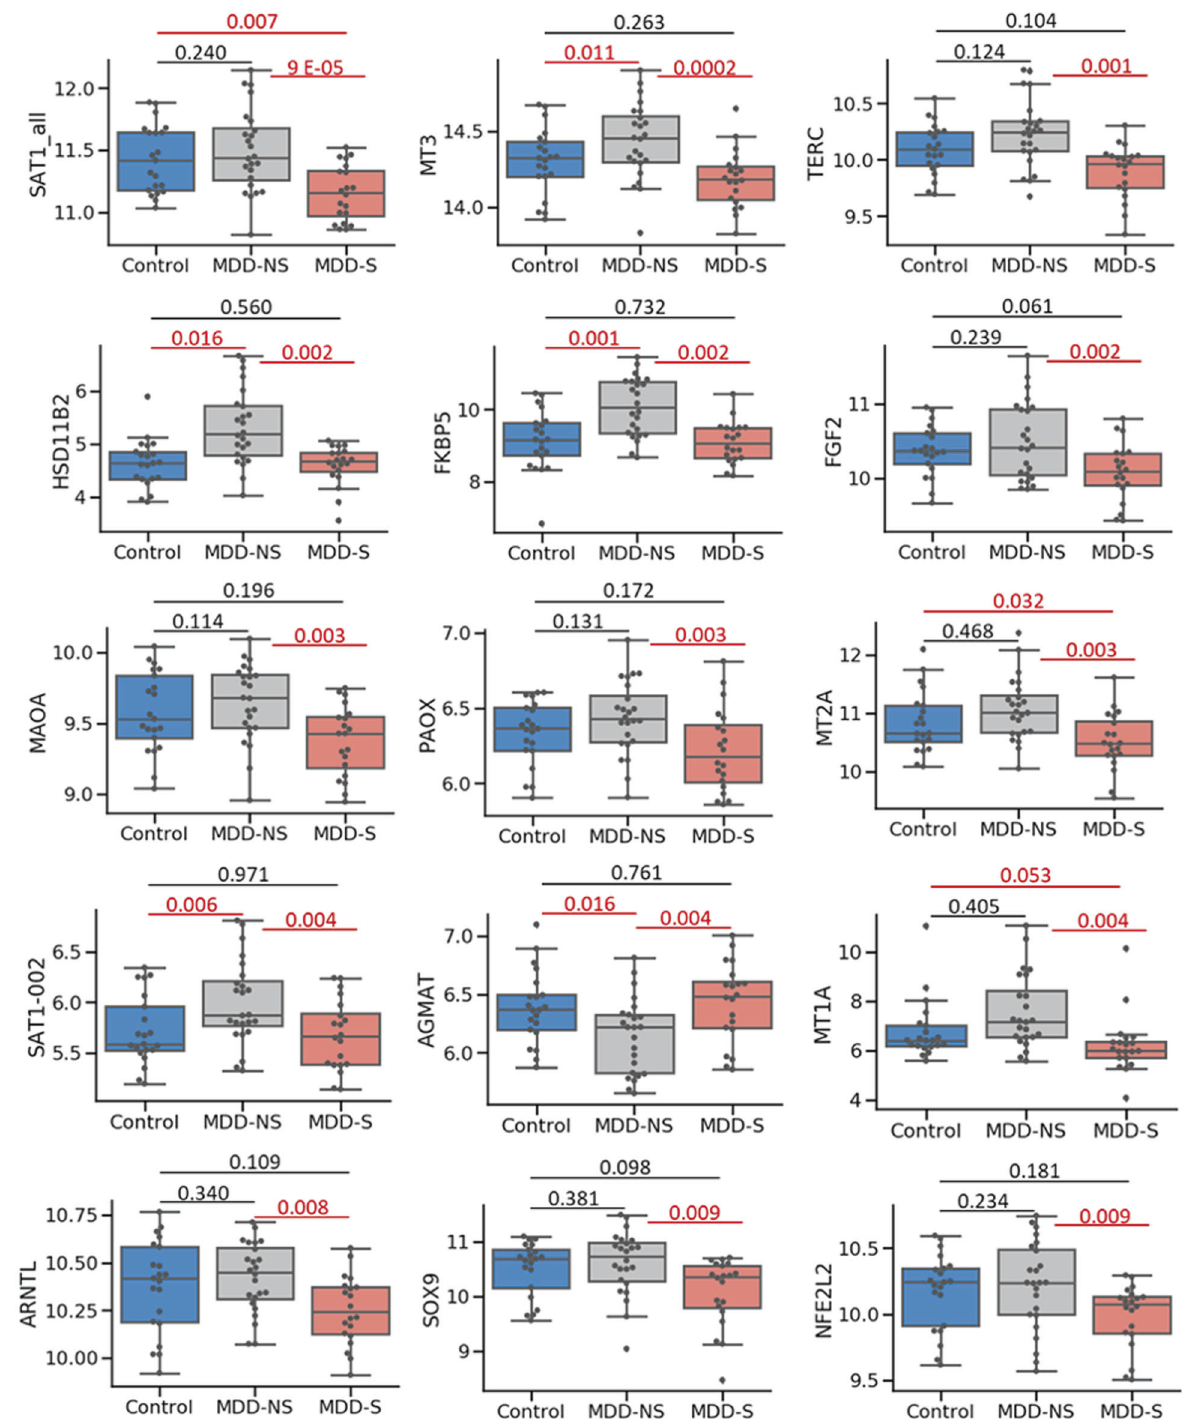
Fig. 2 Genes differentially expressed in brain. Top fi fteen ( p -value ≤ 0.01) differentially expressed genes between MDD-S and MDD-NS in DLPFC. The displayed genes all passed FDR correction for multiple comparisons at Q ≤ (Metallothionein 3) gene, which was decreased in suicides. A (for 16 of the genes)) (Fig. 2 and Table 3). The top gene total of four metallothioneins (MT3, MT2A, MT1A, and MT1X) were differentially expressed between MDD-S and MDD-NS was SAT1. signi fi cantly reduced in MDD-S, although these same genes did In addition to the main SAT1 probe (SAT1_all), measuring all splice not reach signi fi cance in blood. Metallothioneins are known to be variants of the SAT1 gene, two additional splice variant speci fi c involved in neuroprotection against, among other things, the probes (SAT1-002 and SAT1-001) were also signi fi cantly reduced in deleterious effects of long-term increases in cortisol levels [44]. MDD-S (Fig. 2 and Table 3). The second most signi fi cant gene The decreased expression of SAT1 and MT3, as well as other between MDD-S and MDD-NS was the brain-speci fi c, MT3